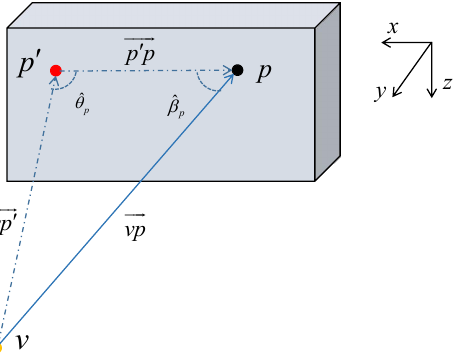
Figure 3. Schematic diagram of the angular transformation of DOA tracking